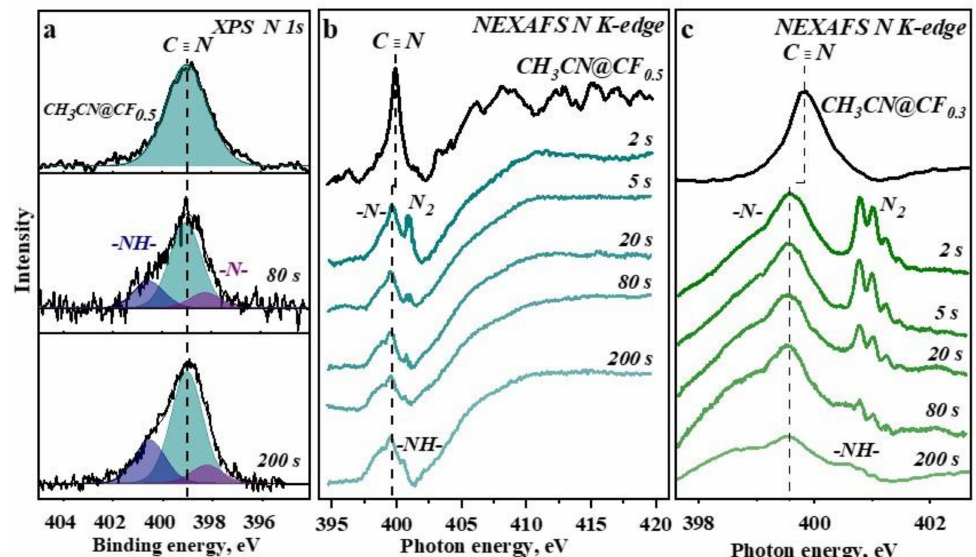
Figure 4. XPS N 1s spectra of initial CH 3 CN@CF 0.5 and that irradiated for 80 s and 200 s ( a ). NEXAFS N K-spectra of CH 3 CN@CF 0.5 ( b ) and CH 3 CN@CF 0.3 ( c ) before and after white beam irradiation for 2 s, 5 s, 20 s, 80 s, and 200